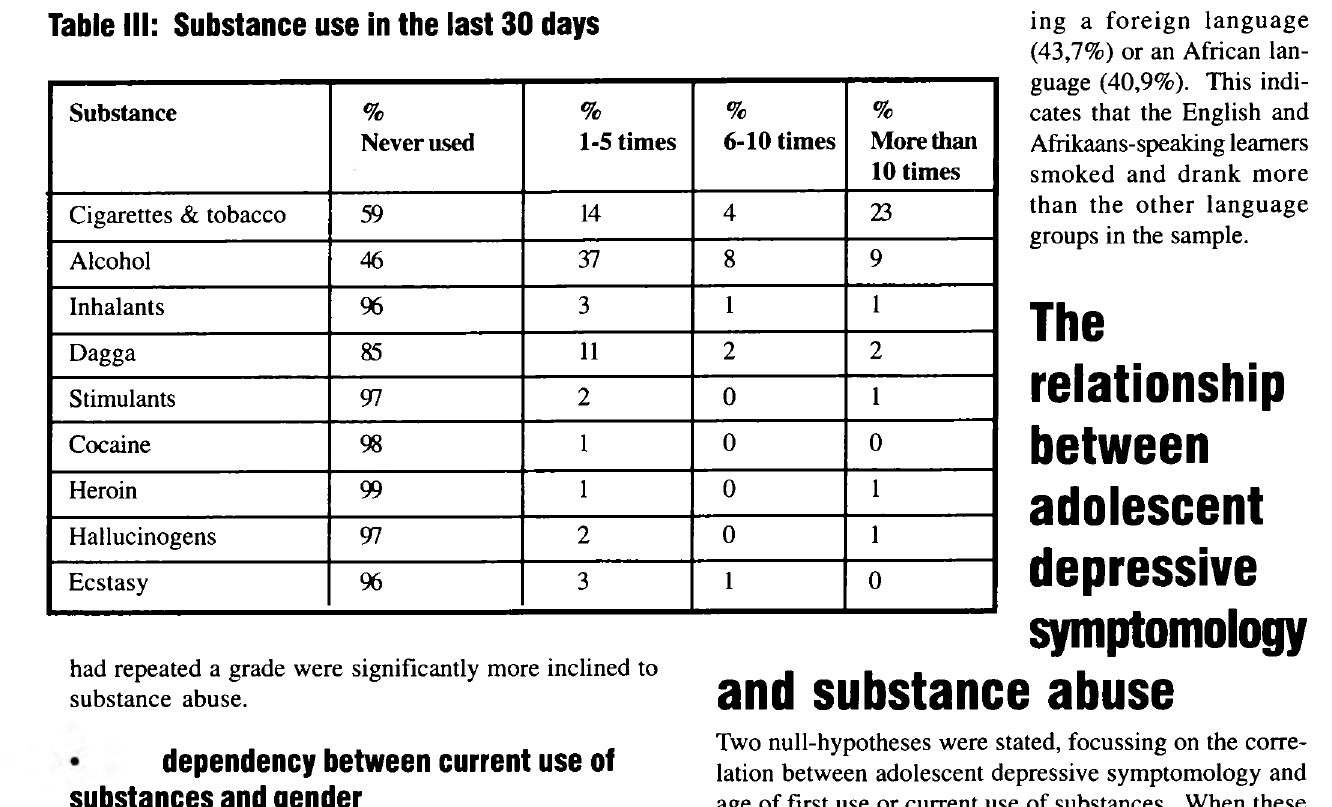
Table III: Substance use in the last 30 days